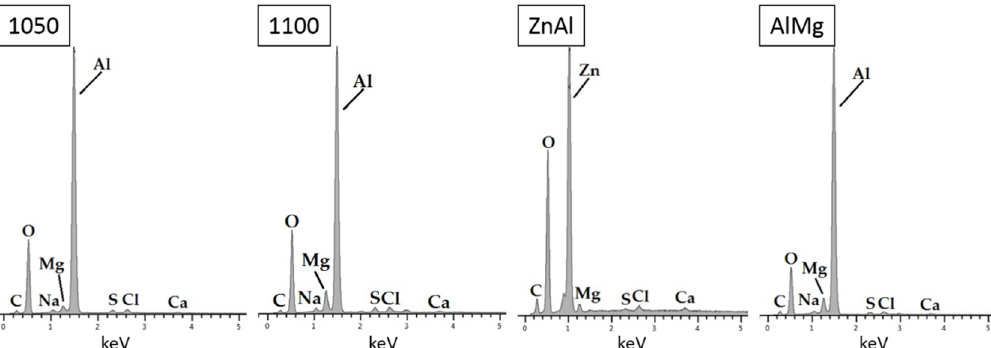
could be due to the presence of hydrotalcite.